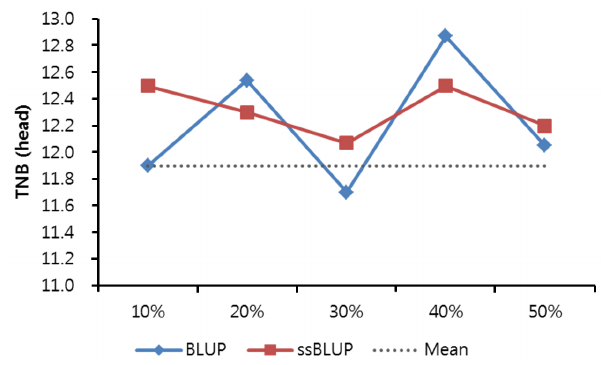
Figure 2. Trends on the total number of piglets born (TNB) by selection ratio and the estimation